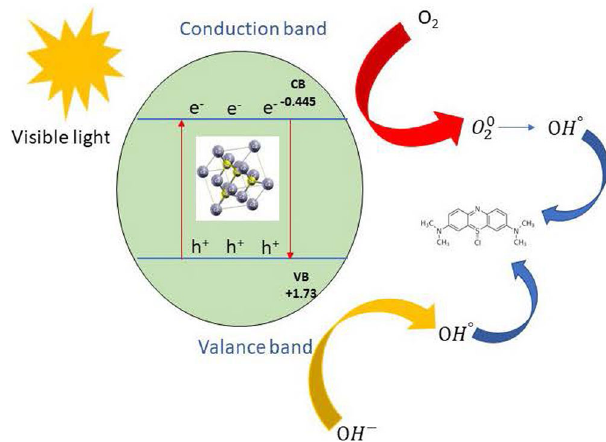
Fig. 6 The proposed mechanism for photodegradation of